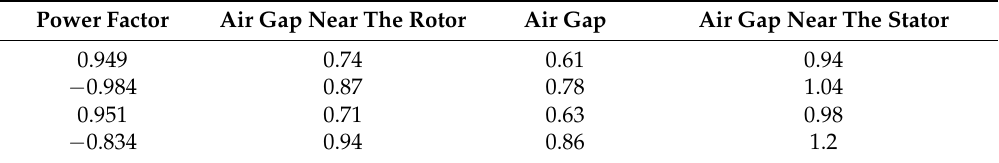
Table 4. Maximum magnetic density at different positions under two conditions of entering phase